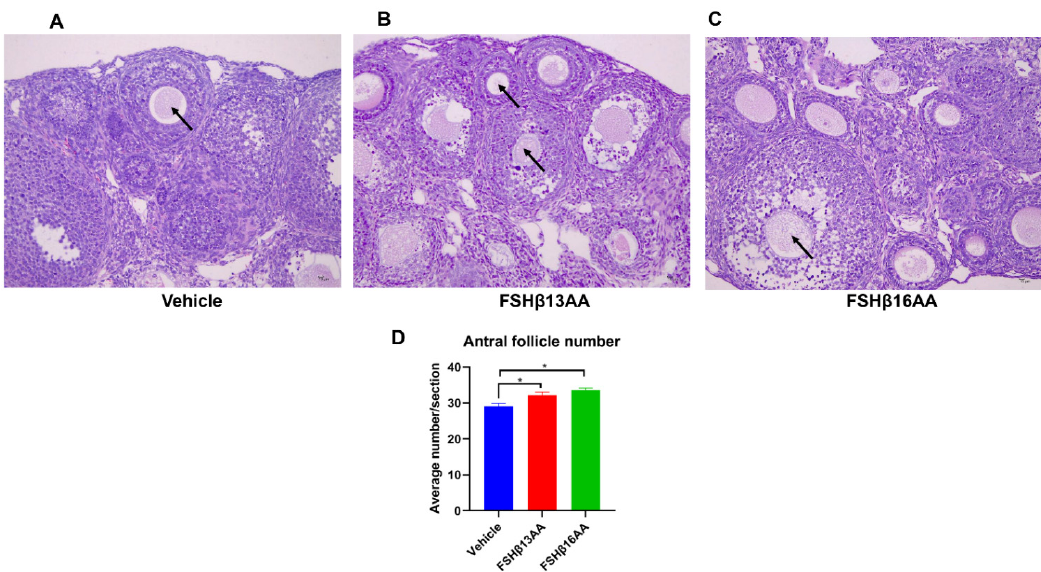
Figure 5. FSH β 13AA/FSH β 16AA on days 25 to 28 promote the ovarian follicular development in prepubertal female mice. Representative images of the antral follicles (arrow) from the vehicle ‐ in ‐ jected control mice ( A ), FSH β 13AA ‐ ( B ) or FSH β 16AA ‐ injected ( C ) females. ( D ) Morphometric anal ‐ yses of the antral follicle number from at least three ovaries/group. Tissues were stained with H&E (×200, scale bar = 10 μ m). Data are mean ± SEM. * p < 0.05.